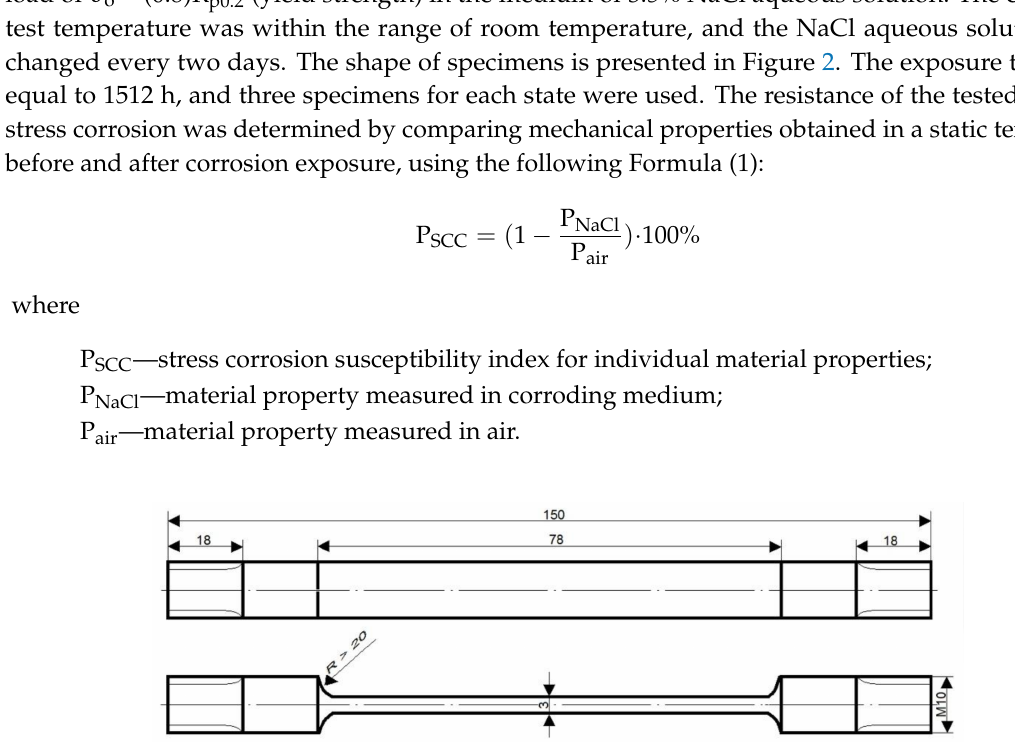
Figure 2. Shape and dimensions of stress corrosion test